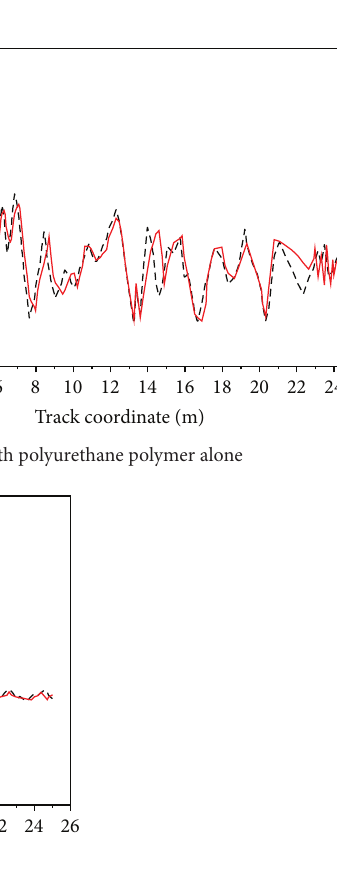
(c) With polyurethane polymer and assistant rails Figure 8: Influence of track stiffness distribution on wheel-rail contact force.